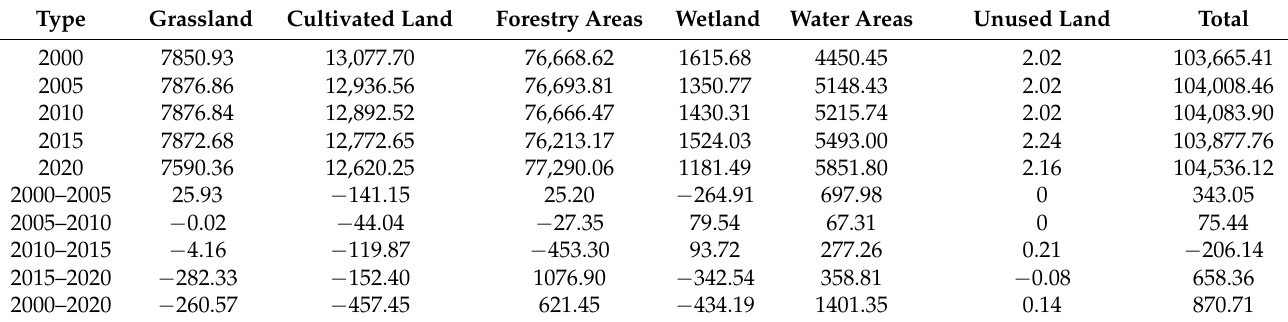
Table 2. ESVs of all land use types in the HAMR from 2000 to 2020 (million yuan). Type Grassland Cultivated